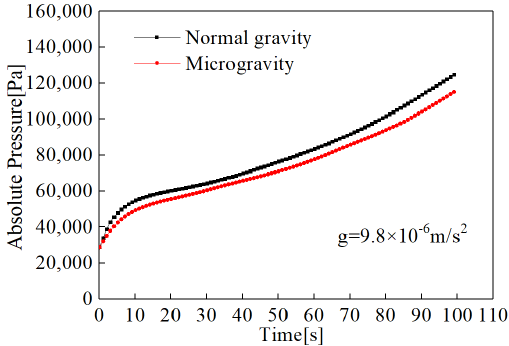
Figure 15. Pressure responses of the no-vent filling process under normal gravity and microgravity.